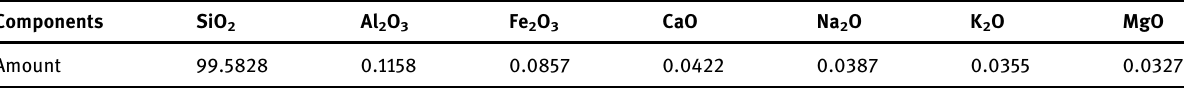
Table 1: The chemical composition of original samples by XRF ( % ) a